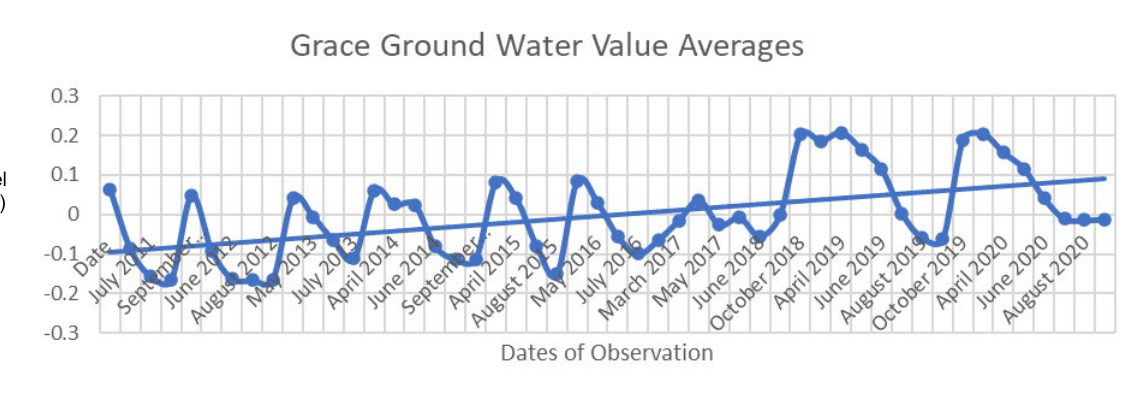
Figure 3. Line graph of average of eight GRACE pixels/point values within and tangential to the Mississippi Delta Physiographic region from 2011 to 2020.